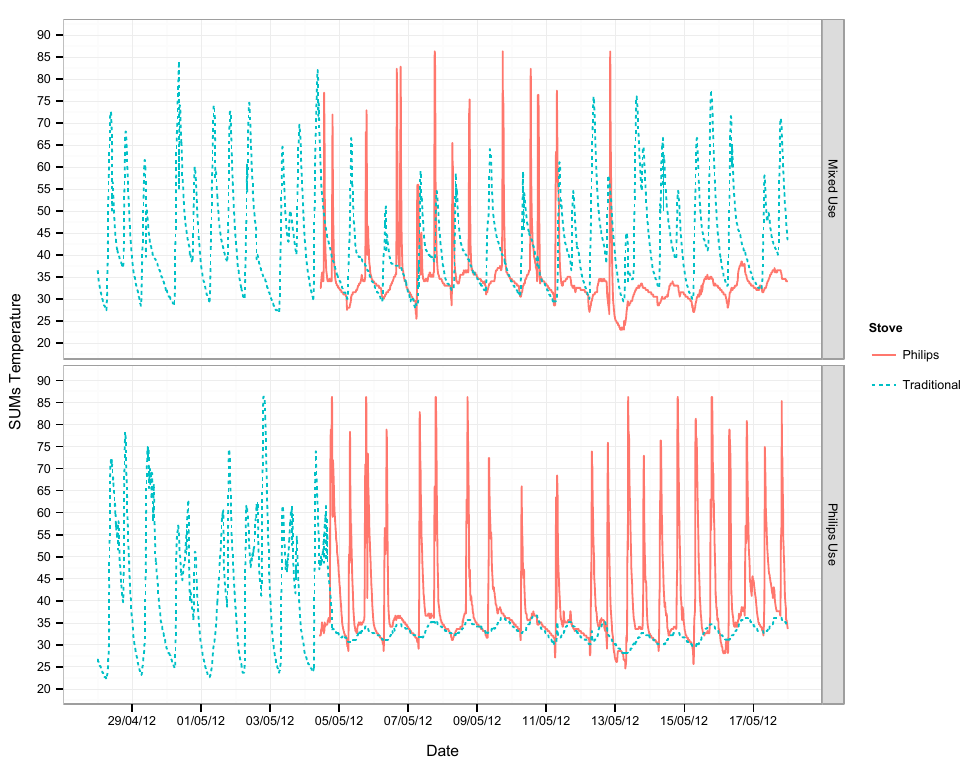
Figure 5. SUMs data from households with different usage patterns. Panels show temperature traces (degrees C) for a traditional stove (blue dashed line) and for the Philips, a fan-assisted intervention stove (solid red line). The top panel shows a household where the stove was incompletely used, with consistent use of both the traditional and intervention stoves. The bottom panel shows a household that moves from their traditional stove to the advanced cookstove. Adapted from [21].